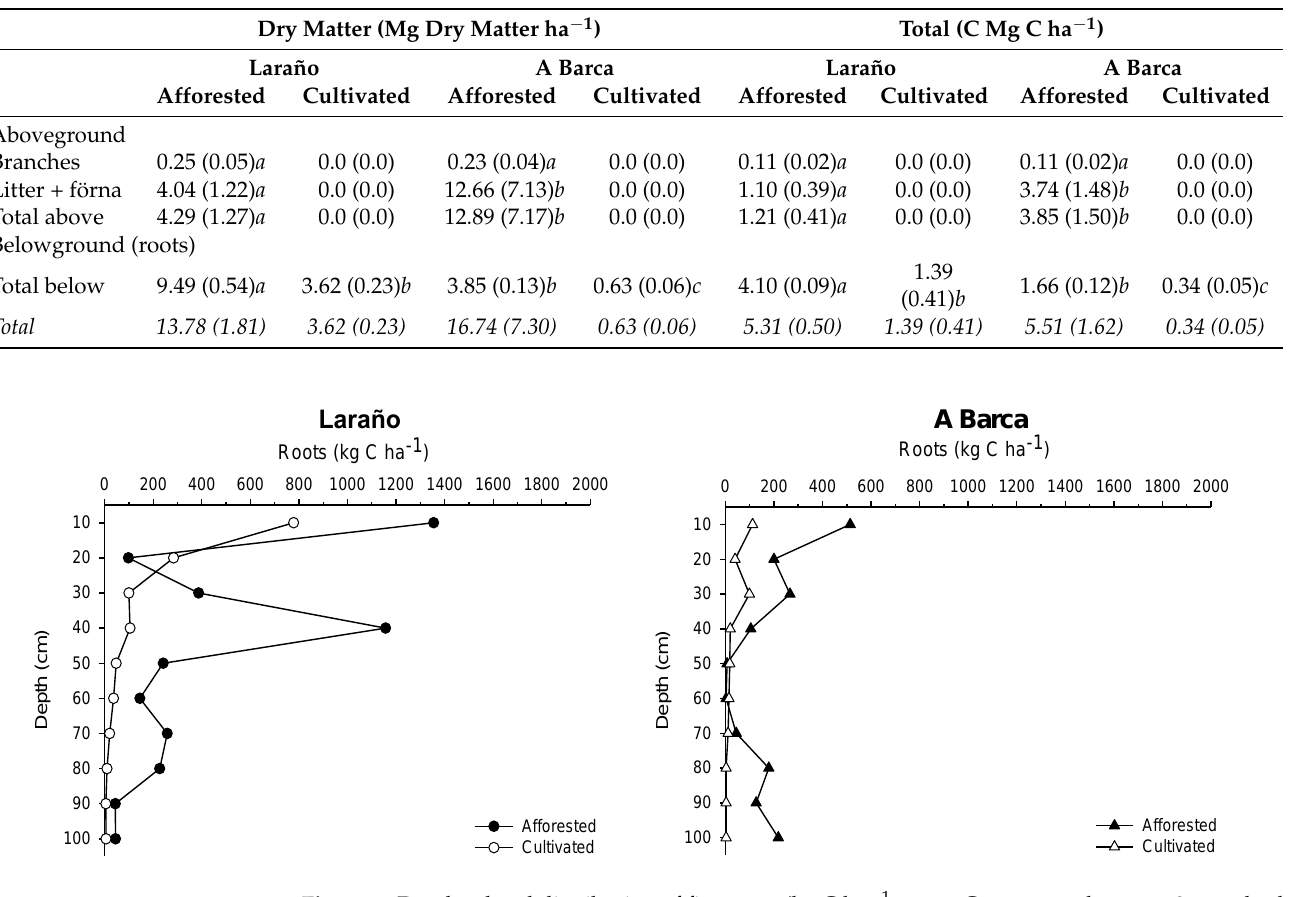
Figure 1. Depth-related distribution of fine roots (kg C ha − 1 ; mean C content values, n = 3; standard deviation of C values lower than the marks) in the soils under study.